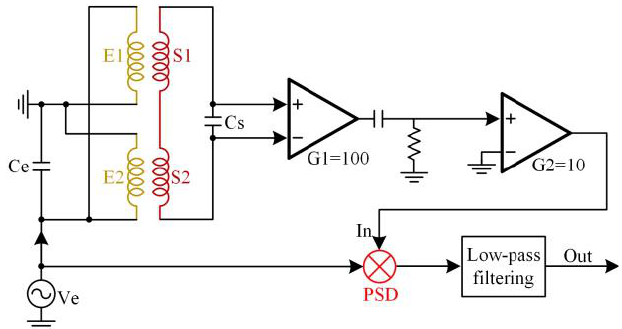
Figure 7. The sensor signal process.